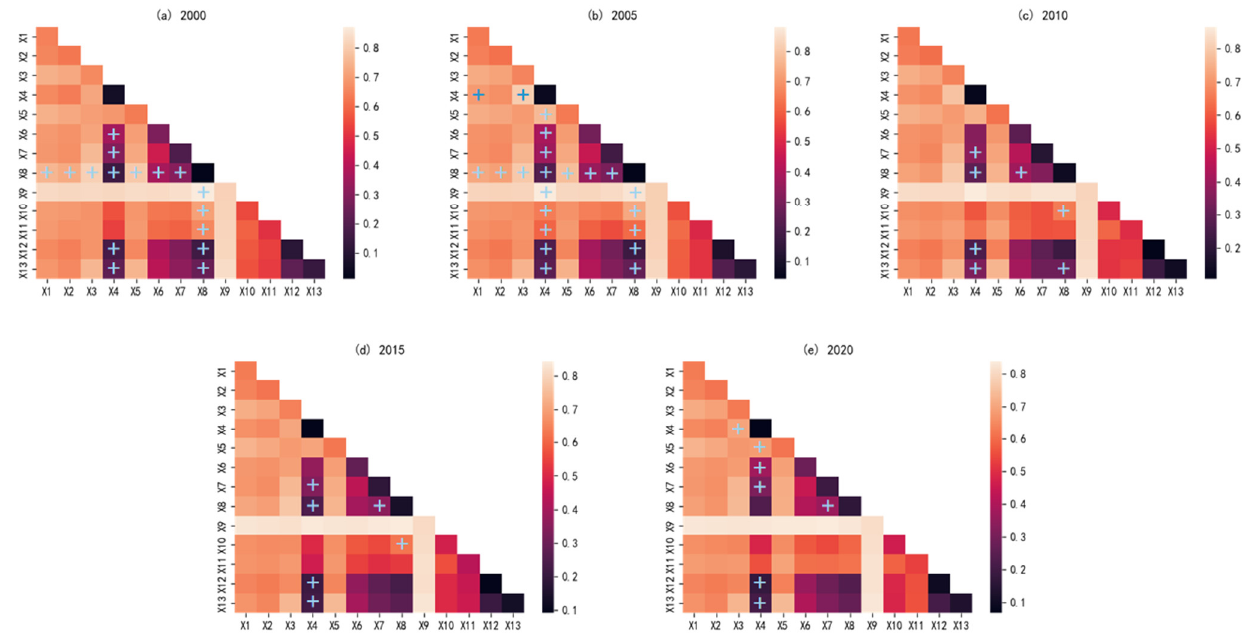
Figure 6. Results of interaction factor detection for the EQI in the Baiyangdian basin. Note: + means that the two detection factors were non-linear enhancement, and no + means that the two detection factors were two-factor enhancement.